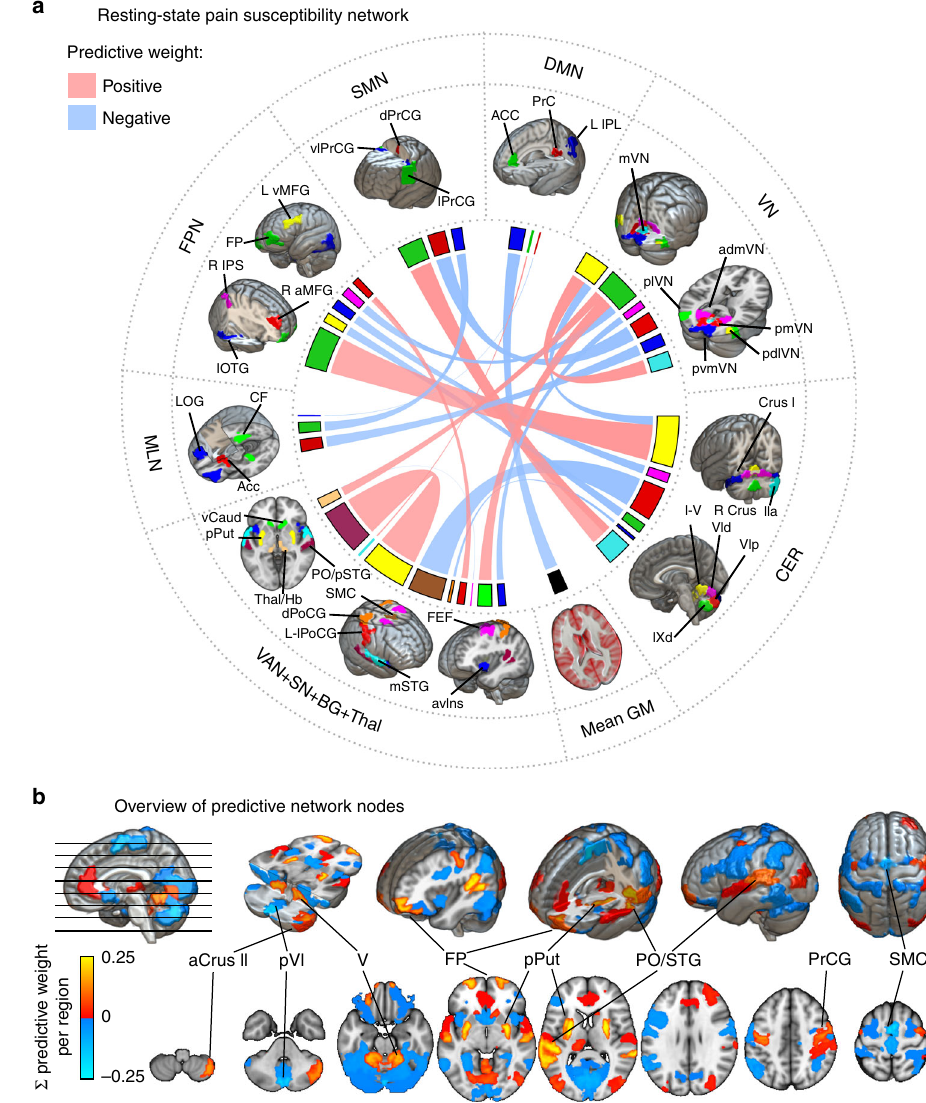
Fig. 3 The resting-state pain sensitivity network signature. a The predictive network of the RPN-signature. Widths of ribbons are proportional to the predictive weights of the functional connections. Network-nodes are color-coded and displayed in 3D-views. Note that, the utilised brain atlas is based on an entirely data-driven functional parcellation and is, therefore, not fully bilateral. Where laterality (L: left, R: right) is not explicitly speci fi ed, the atlas did not distinguish the region from its contralateral homolog. b Regional predictive strength map of the RPN-signature. Colour-bar depicts region-wise predictive strength (sum of the weights of all connections for the region, multiplied by the study-speci fi c regional probability map). Regions with an absolute predictive strength greater than 0.1 are